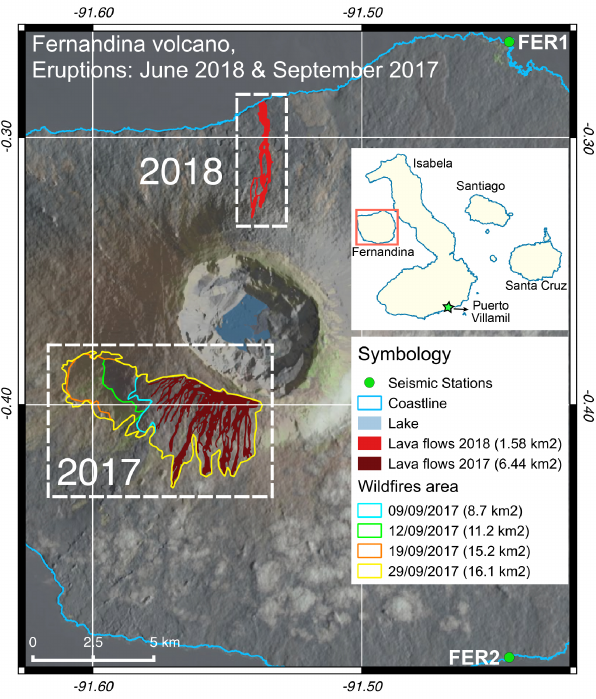
Figure 2: Map of the eruptions of Fernandina volcano in September 2017 and June 2018. Note color lines showing the area burnt by wildfires triggered by the lava flows and the prevailing wind during the 2017 eruption. Green dots are the location of the seismic stations FER1 and FER2. Data provided by: Sentinel- 2: 21 June, 16 July 2018 and 9, 19 and 29 Sept 2017. Landsat-8 12 Sept 2017. Hillshade provided by JAXA. and the red rectangle the location of Fernandina vol- cano.